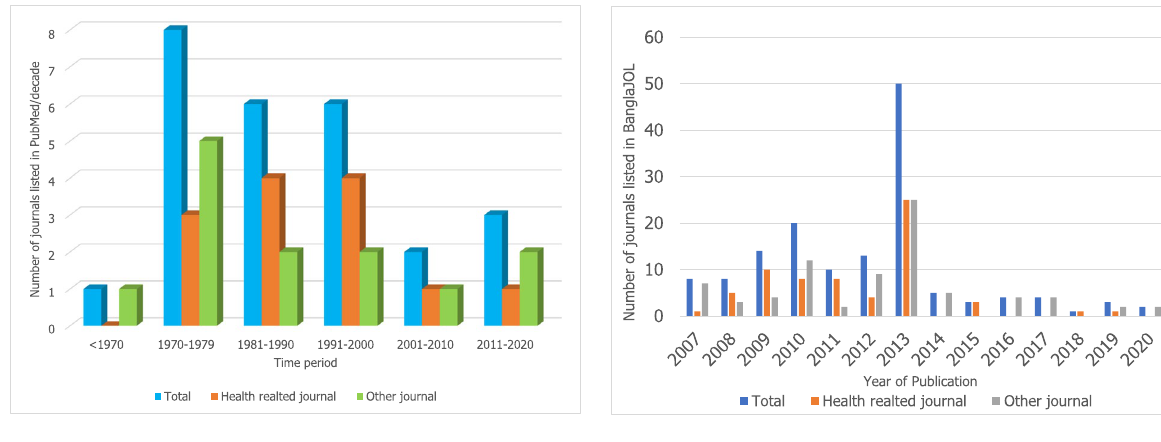
Fig. 1 Trends in the generation of new scientific journals of Bangladeshi origin over time. A Number of listed journals in PubMed per decade. B Number of listed journals per year in